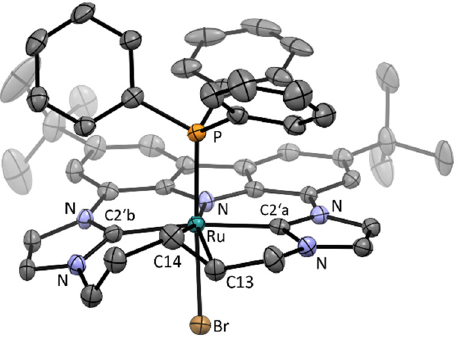
Figure 4. ORTEP-style plot of the molecular structure of complex [Ru(bimca C5H8 )Br(PPh 3 )] ( 5 ) (anisotropic atomic displacement parameters at the 50% probability level). Hydrogen atoms and two molecules of dichloromethane are omitted for clarity.